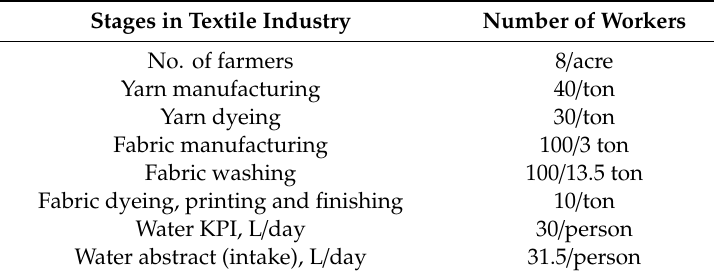
Table A18. Number of farmers / workers involved in cotton cultivation and di ff erent stages of textile industry, which was collected from local